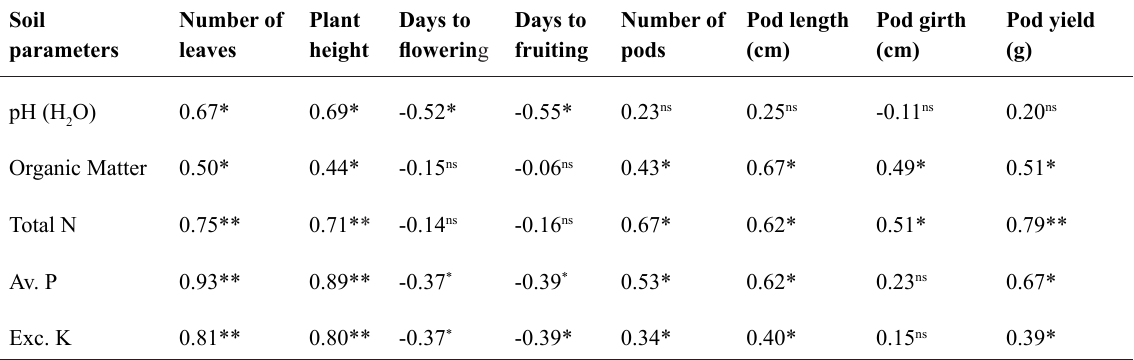
Table 6 Correlation between soil properties and okra growth and yield performance Soil Number of parameters leaves fruiting